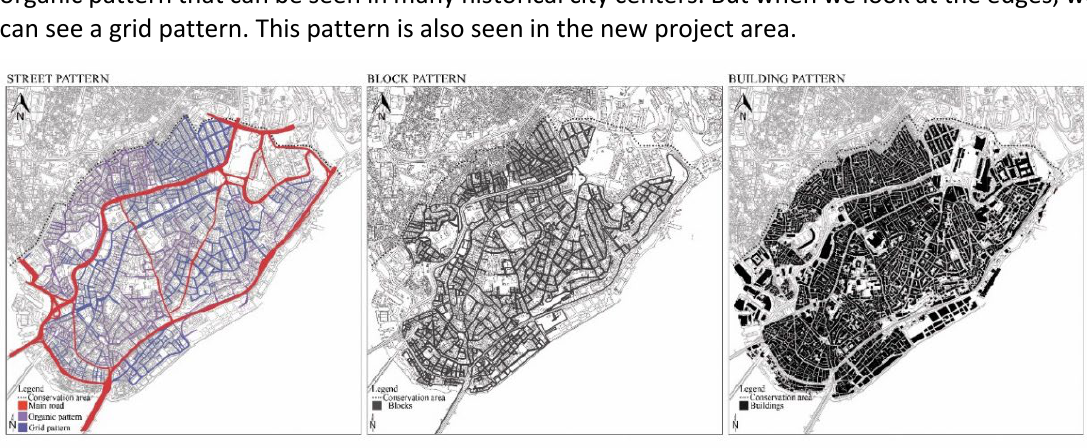
Figure 8 Physical patterns of the study